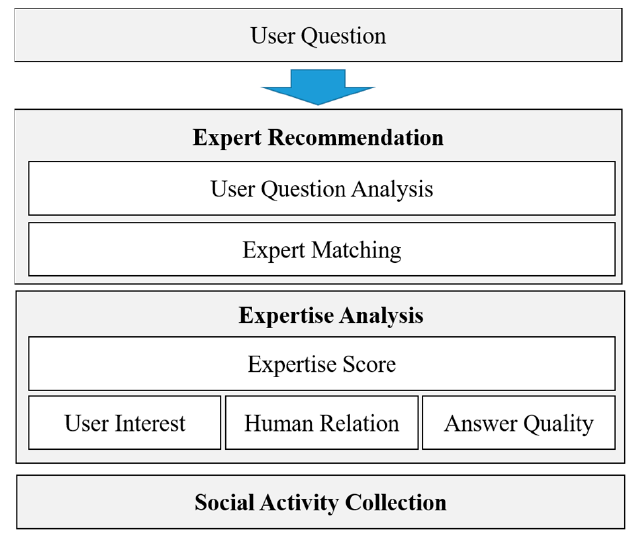
Figure 1. Overall architecture of the expert recommendation method.